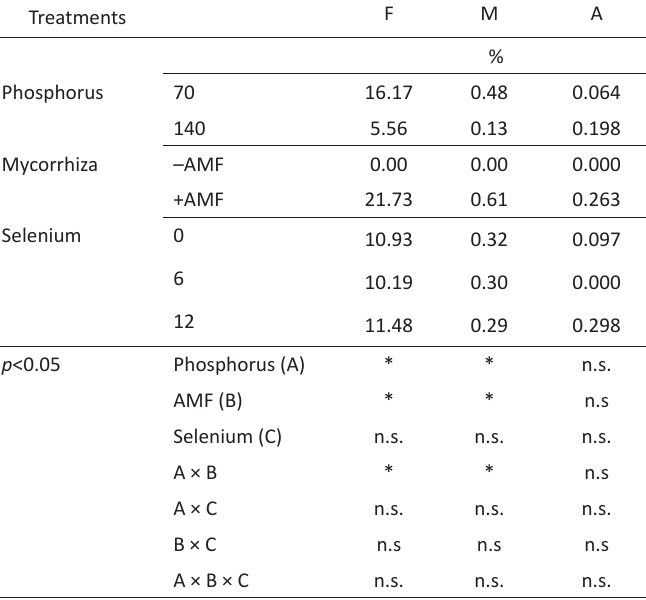
Table 1. Mycorrhizal frequency (F), relative mycorrhizal intensity (M) and relative abundance of arbuscules (A) in lettuce roots grown on medium with different levels of phosphorus and selenium (mg dm -3